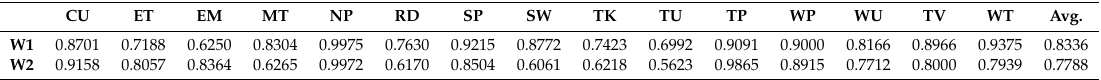
Table 10. F 1 accuracy of the hierarchical fusion results.